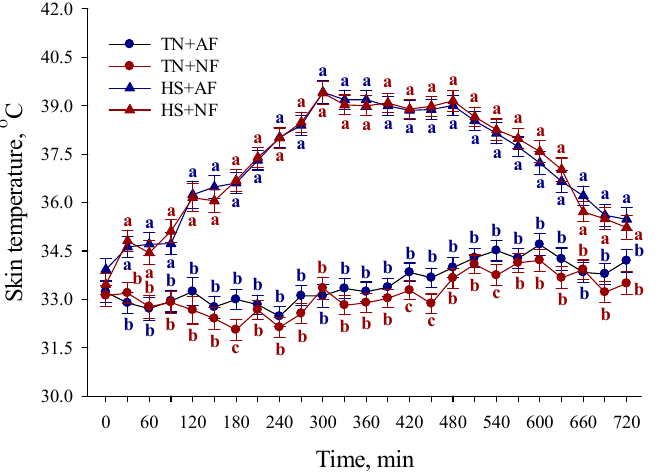
Figure 3. Effects of feed removal on skin temperature recorded every 30 min in finishing pigs during the first 12 h of temperature and feeding treatment period. TN: thermoneutral; HS: heat stress; AF: access to feed; NF: no access to feed. Error bars indicate ± 1 SEM. Letters a, b, and c indicate differences at each 30 min time point ( p < 0.01). Table 2. Serum cytokines measured during the 24 h temperature and feeding treatment (TF) period and the post-TF period (Days 2 and 6) in finishing